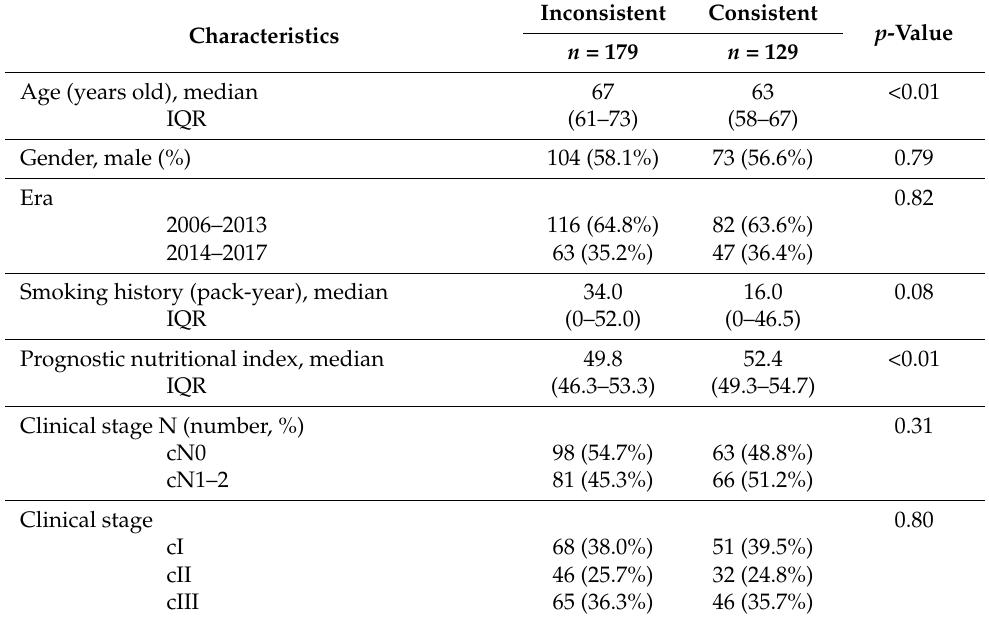
Table 1. Clinicopathological characteristics before propensity